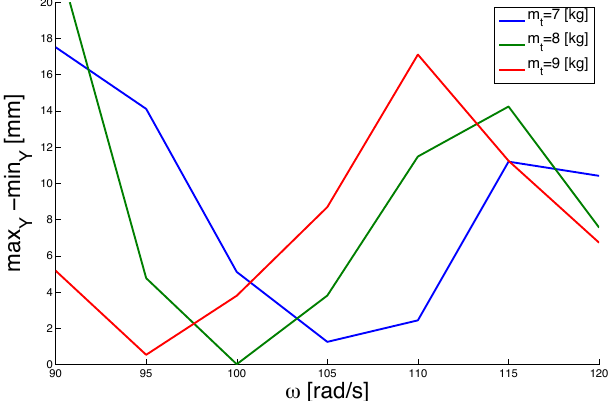
Fig. 7 Peak-to-peak vibrations amplitudes of the rotor frame dependent on the excitation frequency for the mass of the impact element m t from 7 kg to 9 kg. There are no impacts in all these cases.